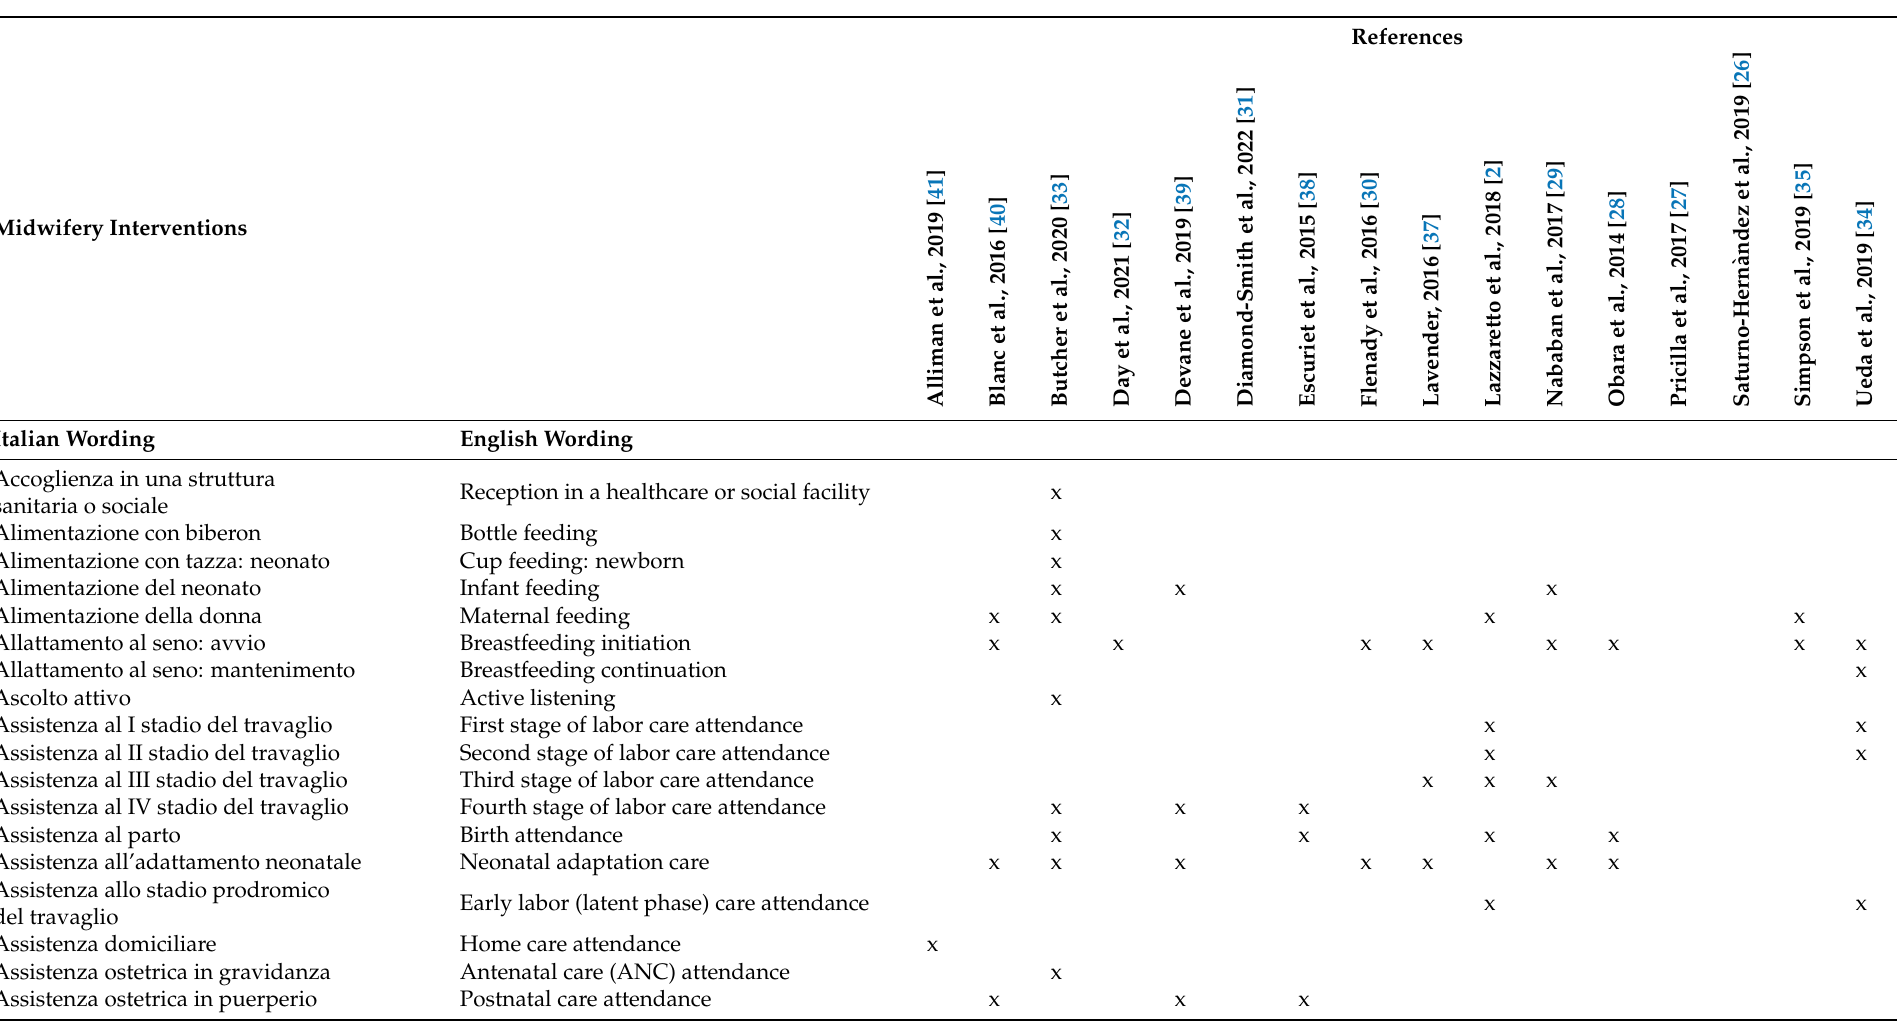
Table 2. Summary of the proposed